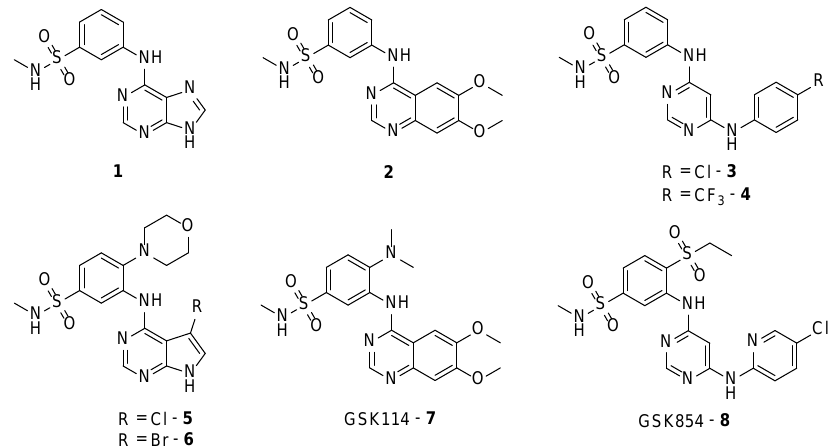
Figure 1. Previously reported TNNi3K inhibitors ( 1 – 8 ).